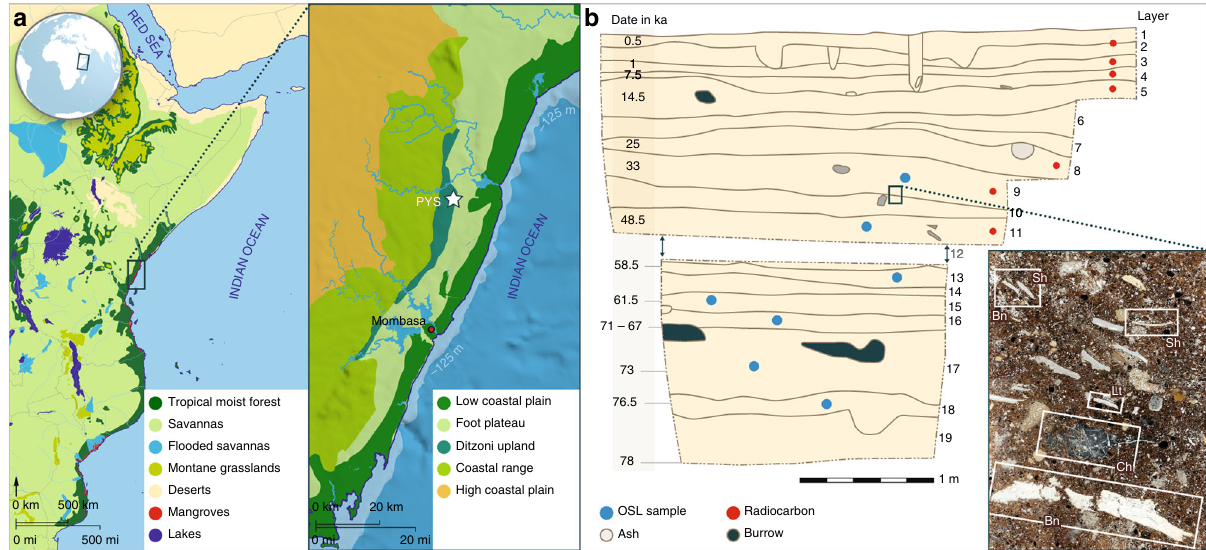
Fig. 1 Environmental setting and PYS stratigraphic section. a The location of PYS in the tropical moist forest of coastal East Africa, situated in the Ditzoni upland, southeastern Kenya. b The stratigraphic sequence of PYS showing the Layers and modeled ages, with example of a micromorphological thin section, illustrating the rich biogenic/anthropogenic contents in the sediments (Sh shell, Bn bone, Lt lithic, Ch charcoal). Note that Layer 12 was not continuous across the whole excavation and did not occur in this section. Age estimates are shown as the median of the highest posterior density